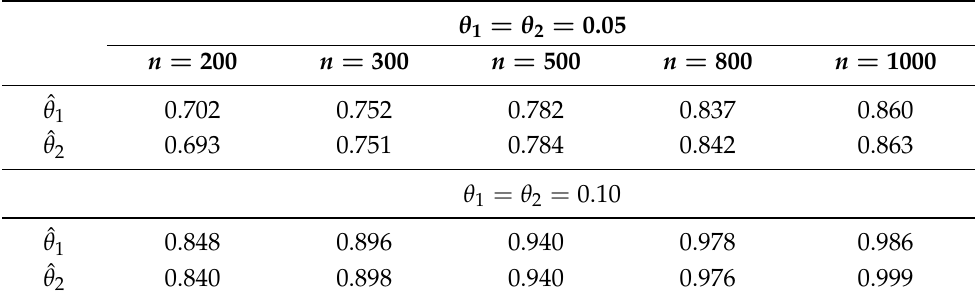
Table 4. The sample proportions of the MLEs of ˆ θ 1 > 0 and ˆ θ 2 > 0 based on 10,000 runs.